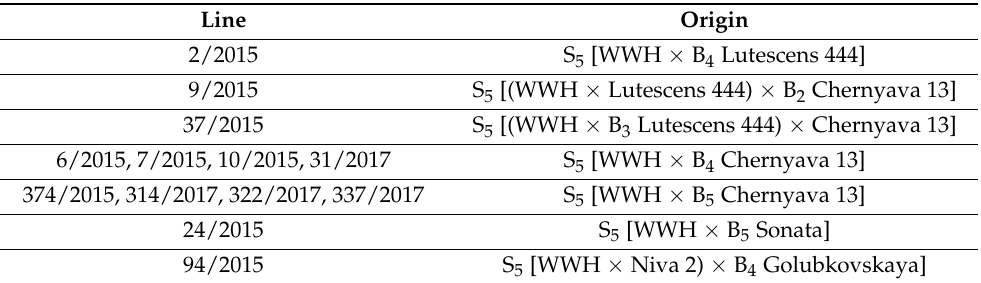
Table 1. The origin of introgressive lines of spring common wheat with genetic material of Thinopyrum ponticum